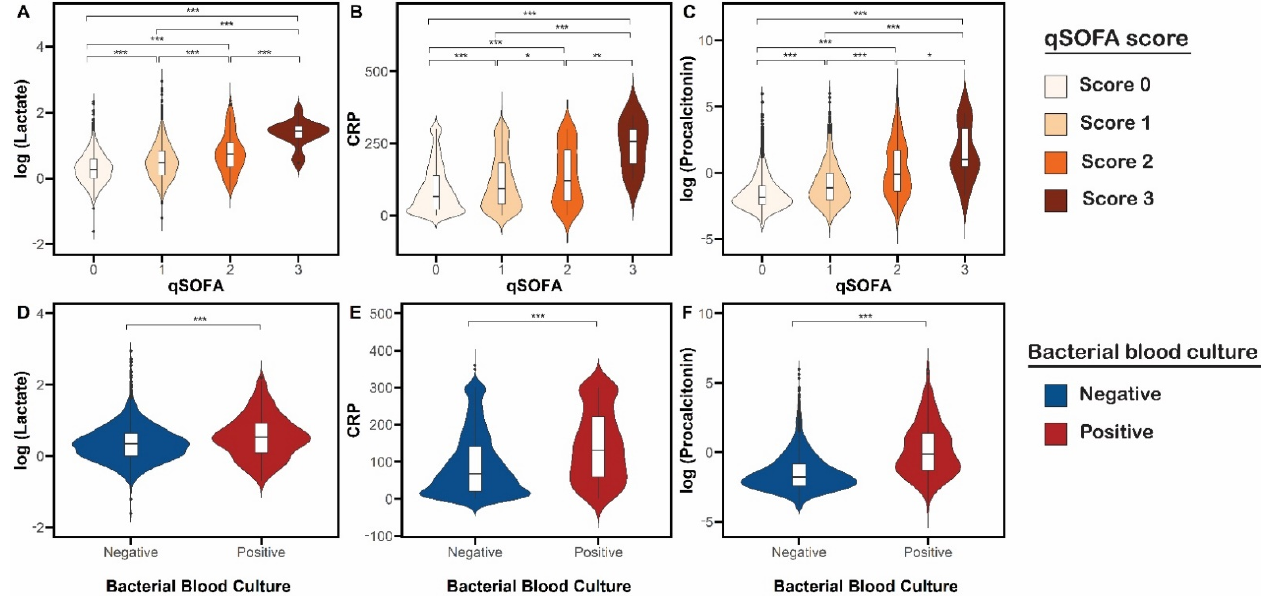
Figure 1. Variation of infection/sepsis biomarker levels stratified by quick sequential organ failure assessment (qSOFA) scores and bacterial blood culture results in cancer patients presenting to the emergency department with suspected infection. Upper panel: Distribution of ( A ) lactate, ( B ) C-reactive protein (CRP), and ( C ) procalcitonin levels by qSOFA score. A one-way analysis of variance followed by the post hoc Tukey test was used for statistical analysis. Lower panel: Distribution of ( D ) lactate, ( E ) CRP, and ( F ) procalcitonin levels for positive and negative bacterial blood culture results. The Wilcoxon-Mann-Whitney test was used for statistical analysis. * p < 0.05; ** p < 0.01; *** p < 0.001.